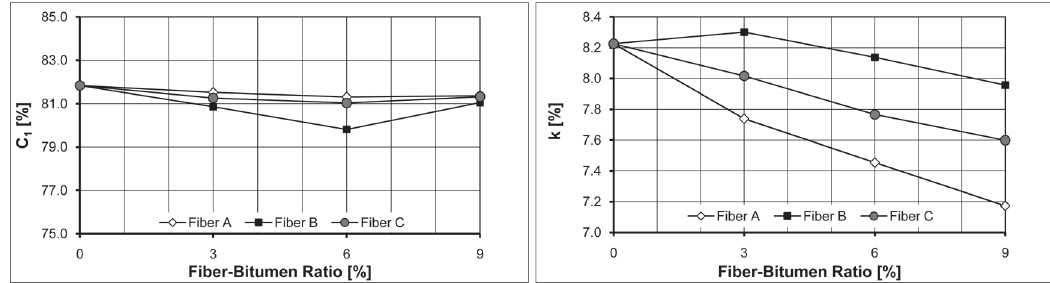
Fig. 8. Compaction parameters of bituminous